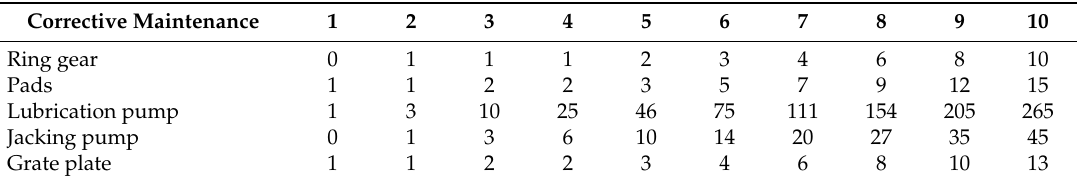
Table 11. Nc projected values (year 1 to year 10).